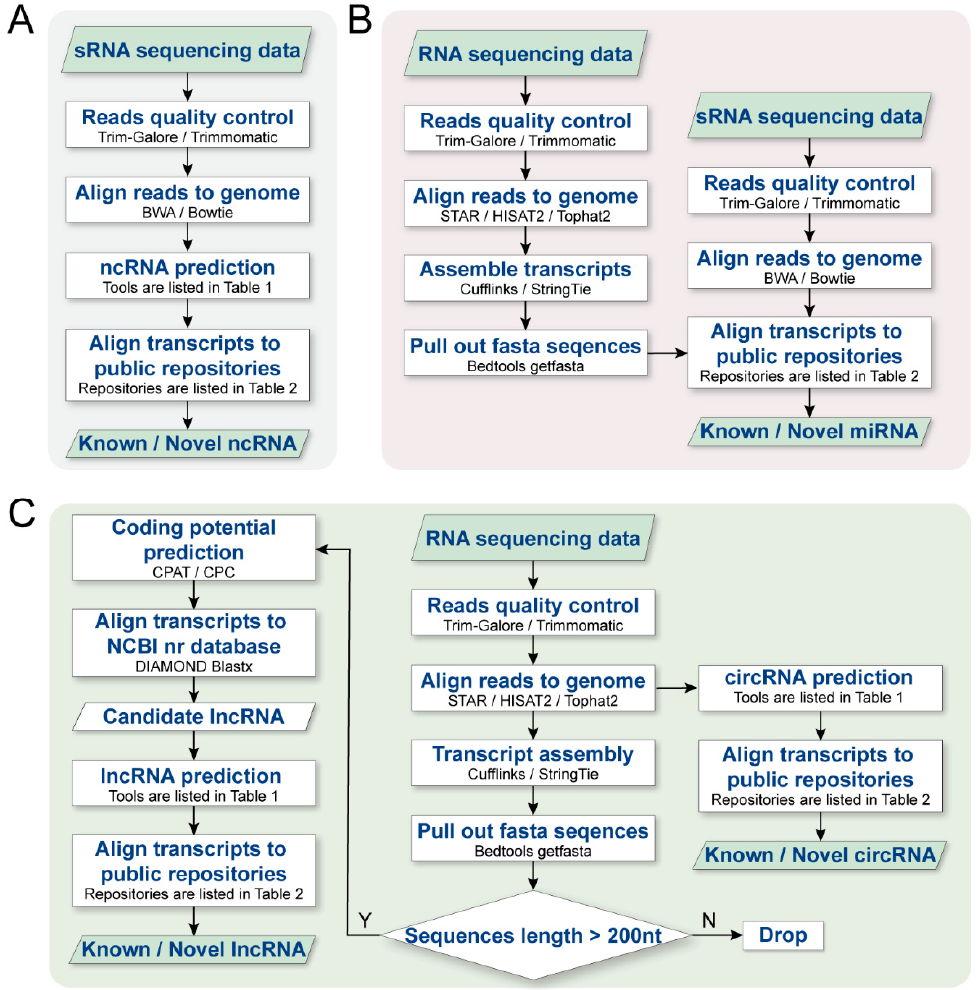
Figure 3. The analysis workflow for differentiating between different classes of ncRNAs in sRNA- seq/RNA-seq datasets. ( A ) General analysis workflow from sRNA-seq data to ncRNA prediction (including data preprocessing, sequence alignment, ncRNA prediction, and related database align- ment), ( B ) represents the general analysis process from RNA-seq to lncRNA/circRNA prediction (the lncRNA analysis process includes data preprocessing, sequence alignment, transcript assembly, sequence length filtering, transcript encoding potential estimation, database alignment, and lncRNA prediction. The circRNA analysis process includes data preprocessing, sequence alignment, circRNA prediction, and related database alignment), ( C ) represents the general process from sRNA-seq/RNA- seq to miRNA prediction (where analysis process from RNA-seq to miRNA prediction is like the general analysis process in A, while sRNA-seq to miRNA prediction includes data preprocessing, sequence alignment, miRNA prediction, and related database